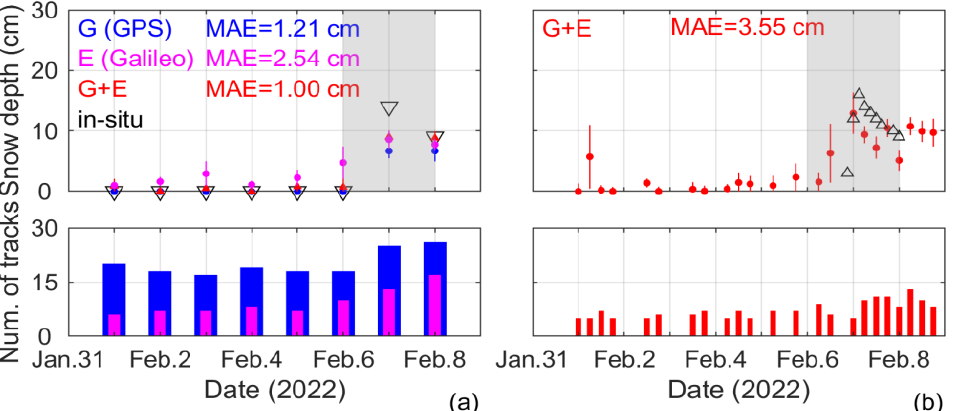
Figure 4. The daily and 6 h snow depth results for Site “CZCZ”. ( a ) Daily results of GPS (G), Galileo (E), and GPS + Galileo combinations (G + E). ( b ) The 6 h G + E results. The error bars are defined as the standard errors of all of the available tracks. the standard errors of all of the available